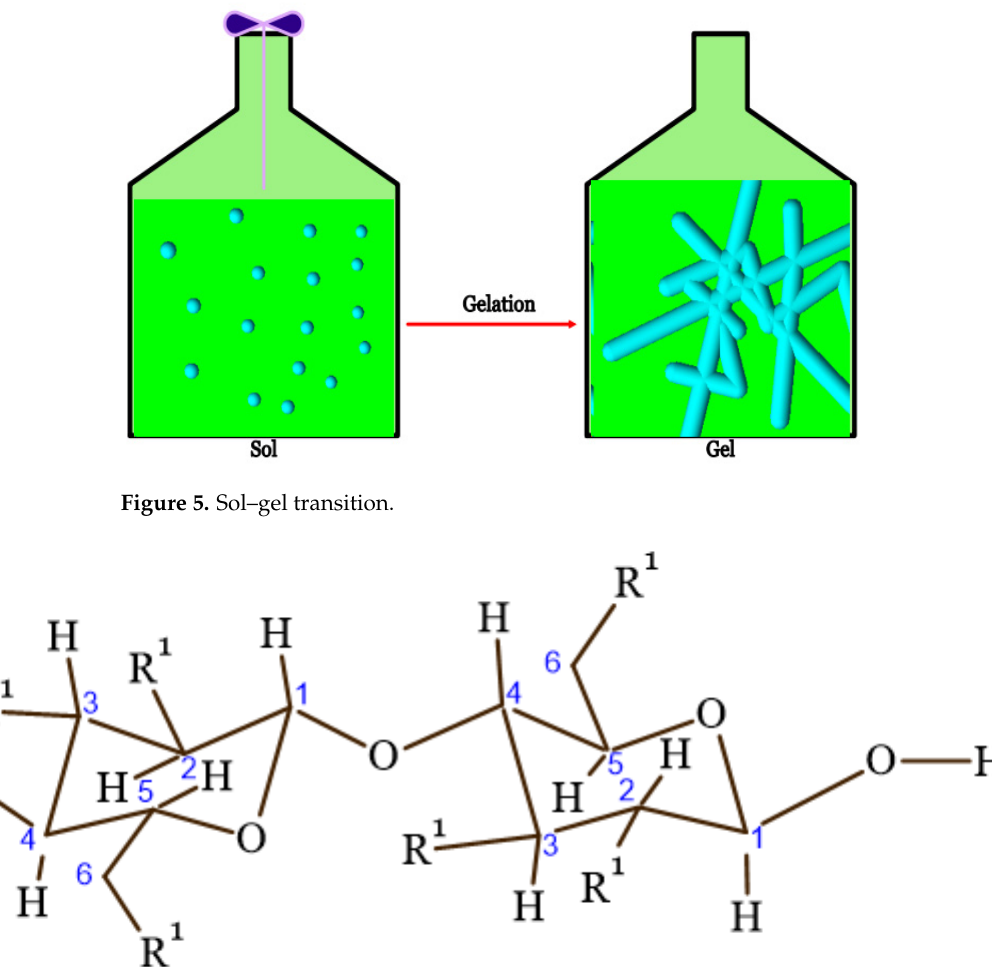
Figure 5. Sol–gel transition.